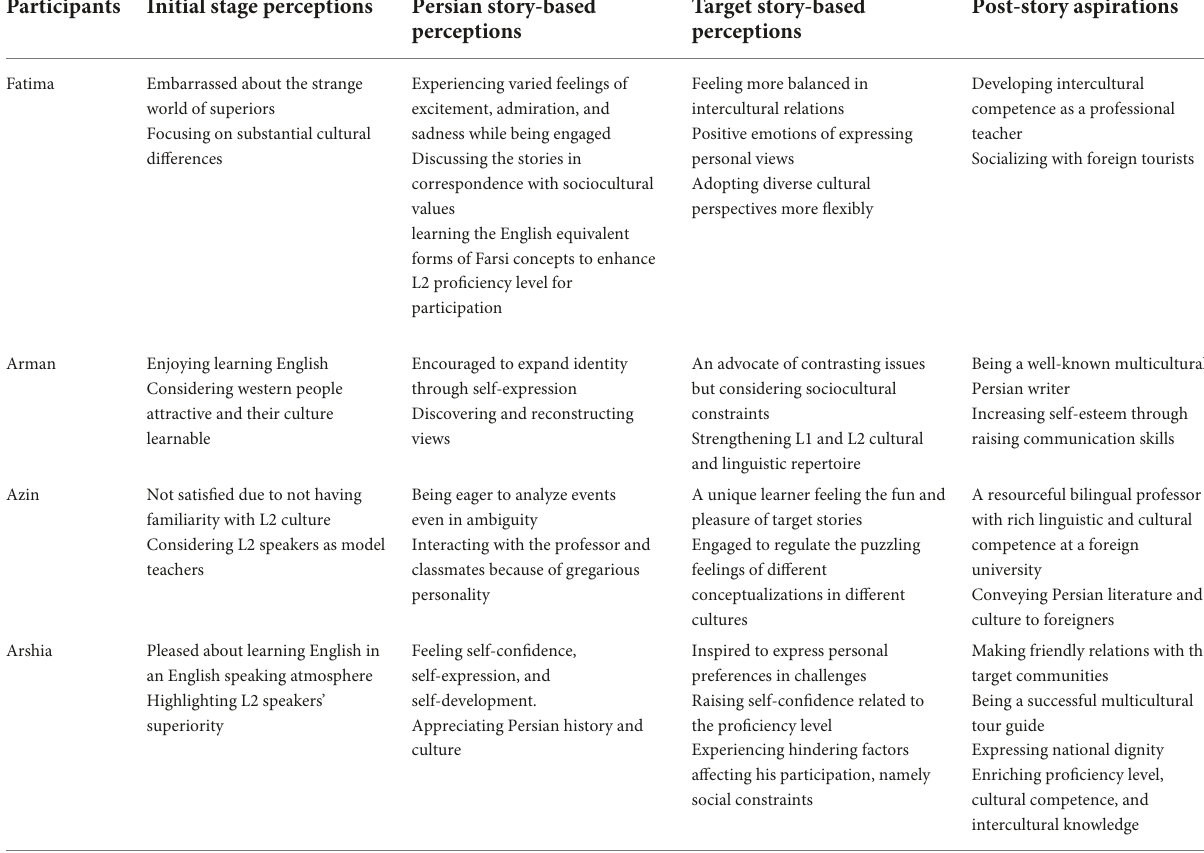
TABLE 7 Individual self-images in pre, while and post story-based instruction stages.